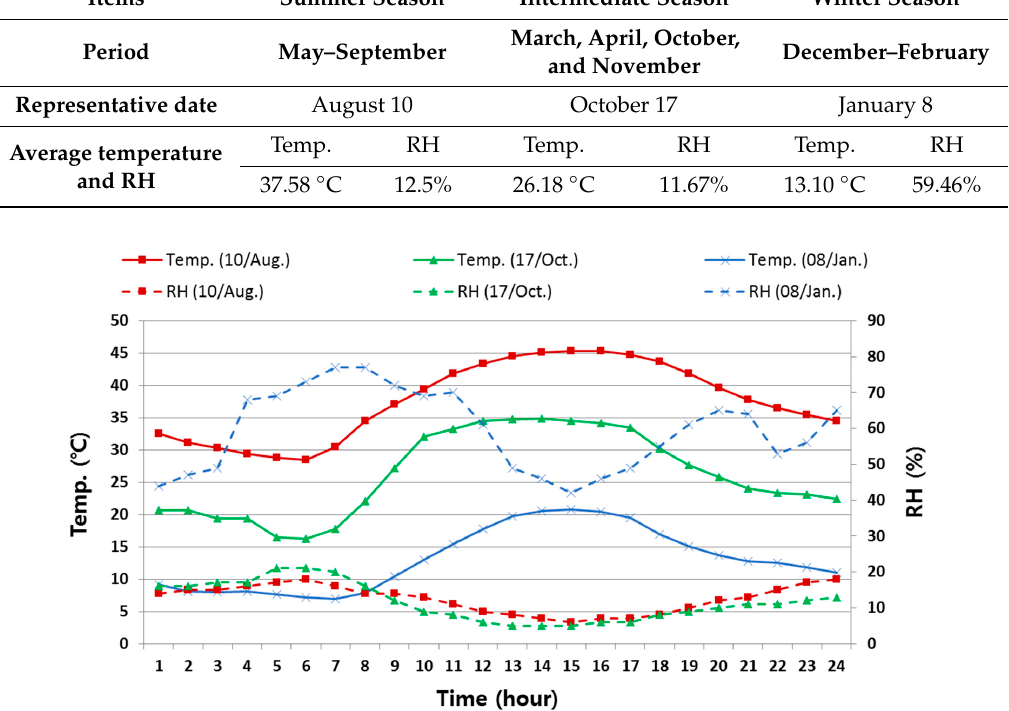
Table 4. Average temperature and humidity of each representative day.